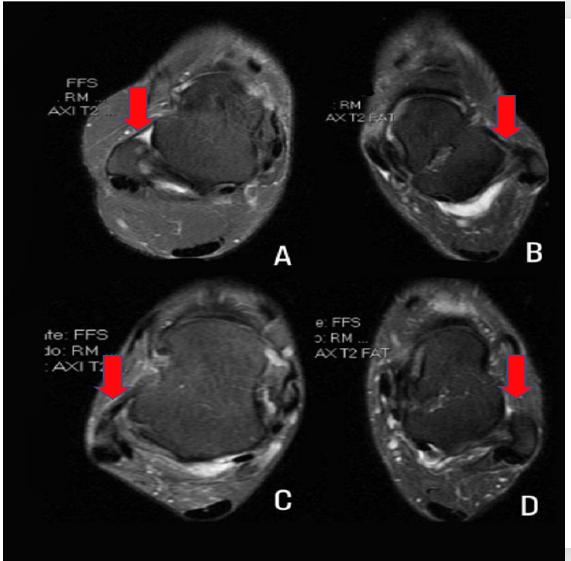
Figure 3. MRI of the ankle in a T2-weighted axial section at the height where the talus is most visible for ATFL analysis. ( A ): normal ligament (rectilinear and homogeneous); ( B ): abnormal ligament due to altered signal; ( C ): abnormal ligament due to altered contours; and ( D ): absent